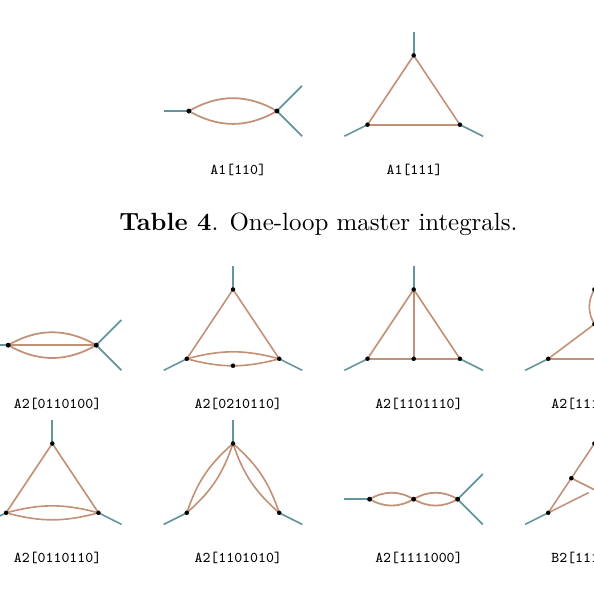
Table 5 . Two-loop master